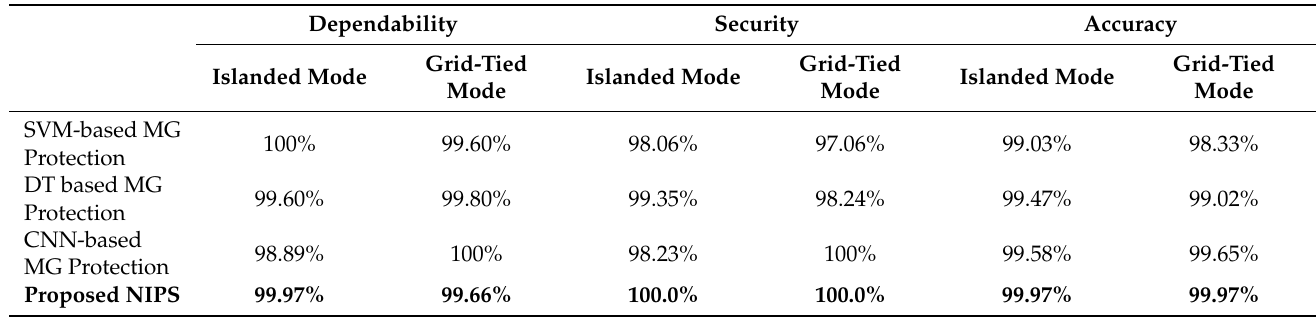
Table 6. Performance comparison of the proposed NIPS with existing intelligent schemes.